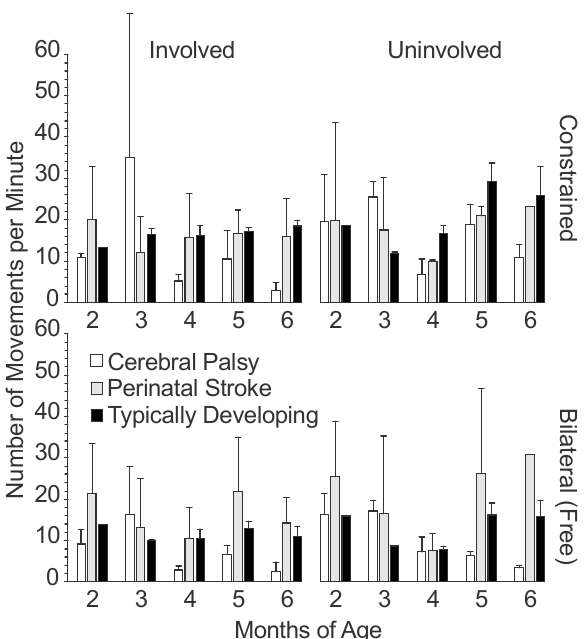
Figure 6. Mean movement frequency by age, side, and condition. For typically developing infants, the left arm is plotted alongside the involved limb and the right arm is plotted alongside the uninvolved limb. Error bars show 1 standard deviation.